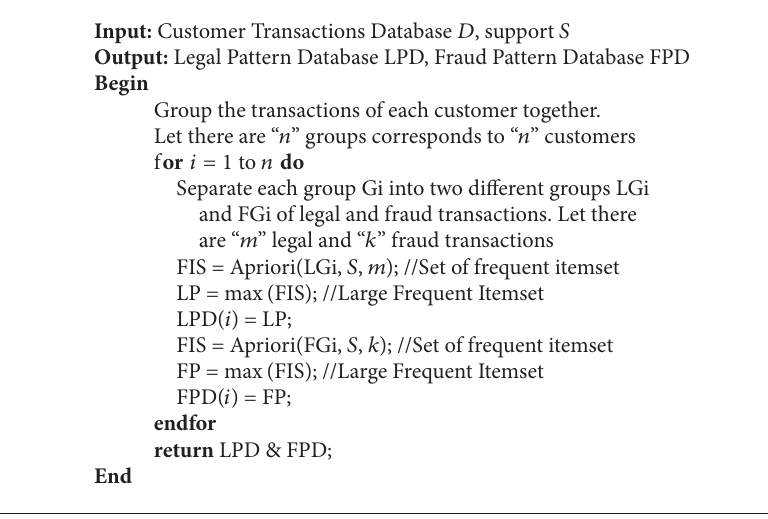
Algorithm 1: Training